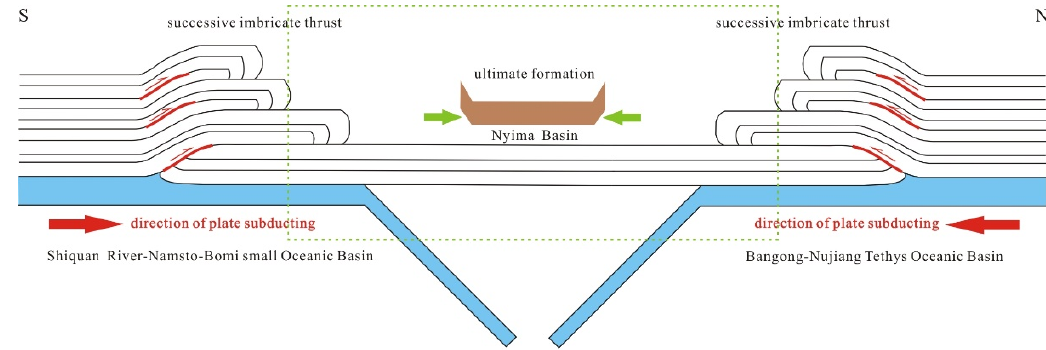
Figure 14. Formation mechanism of thrust structure in hedging type in the Nyima